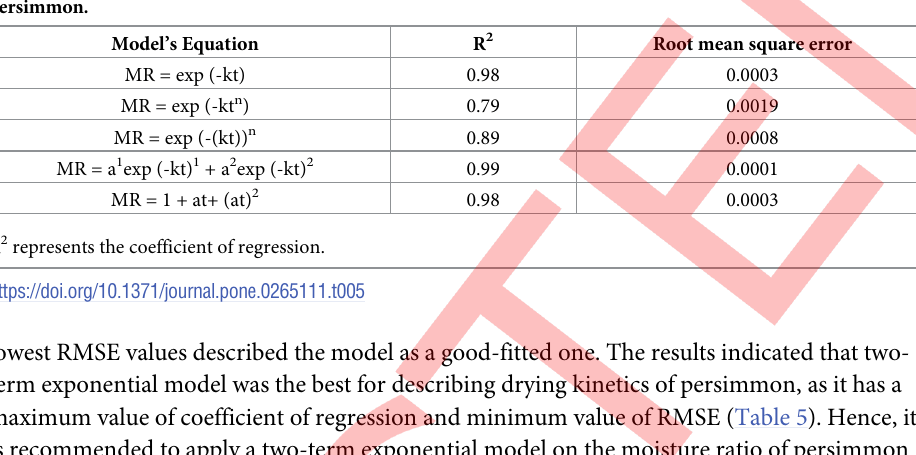
Table 5. Coefficient of regression and root mean square error of published equations for drying kinetics of persimmon. Model’s Equation R 2 Root mean square error MR = exp (-kt)